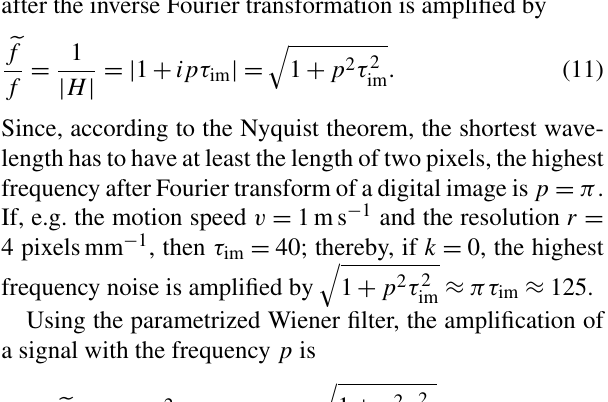
can be calculated from Eq. (2) (Oswald-Tranta et al., 2010a):